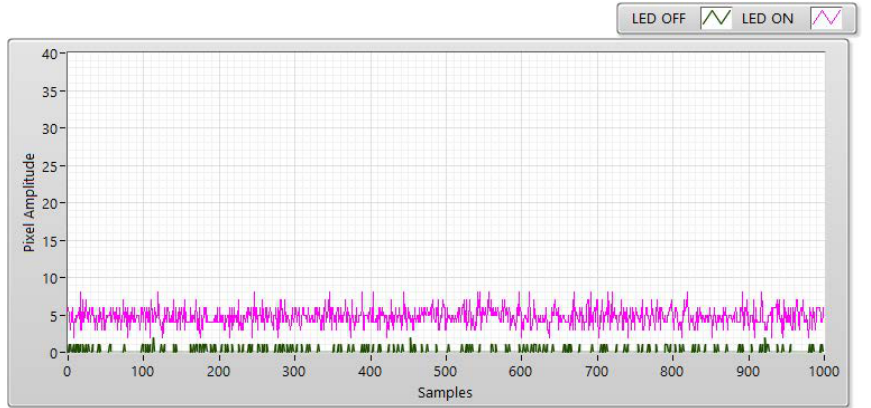
Figure 9. SNR measurement with a Point Grey rolling shutter camera at a communication distance